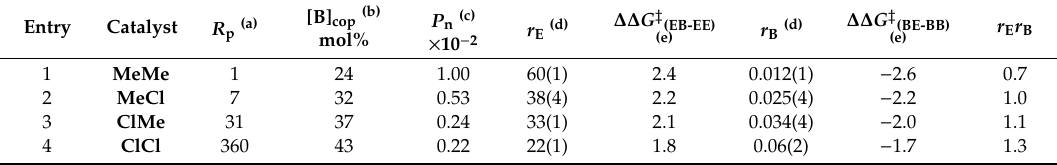
Table 1. Experimental results for catalysts R 1 R 2 in ethene / 1-butene (E / B)